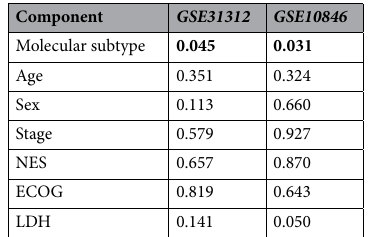
Table 3. Correlation between the IPI components and RTN1 expression. Significant P value was